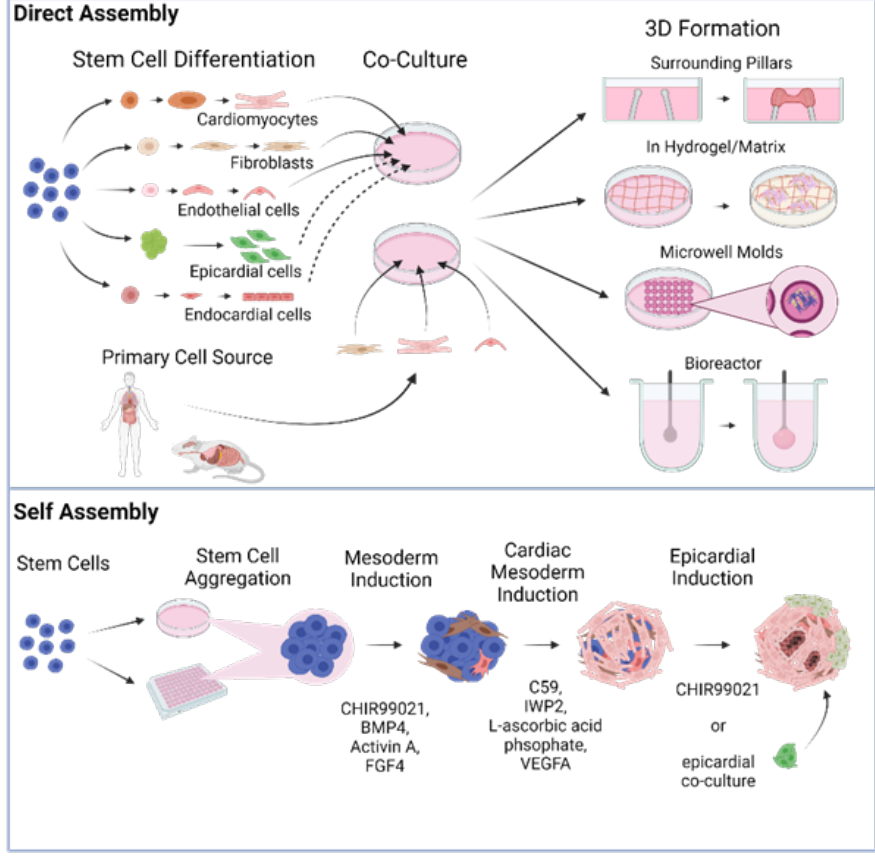
Figure 1. Different fabrication approaches for cardiac organoid generation in a dish.